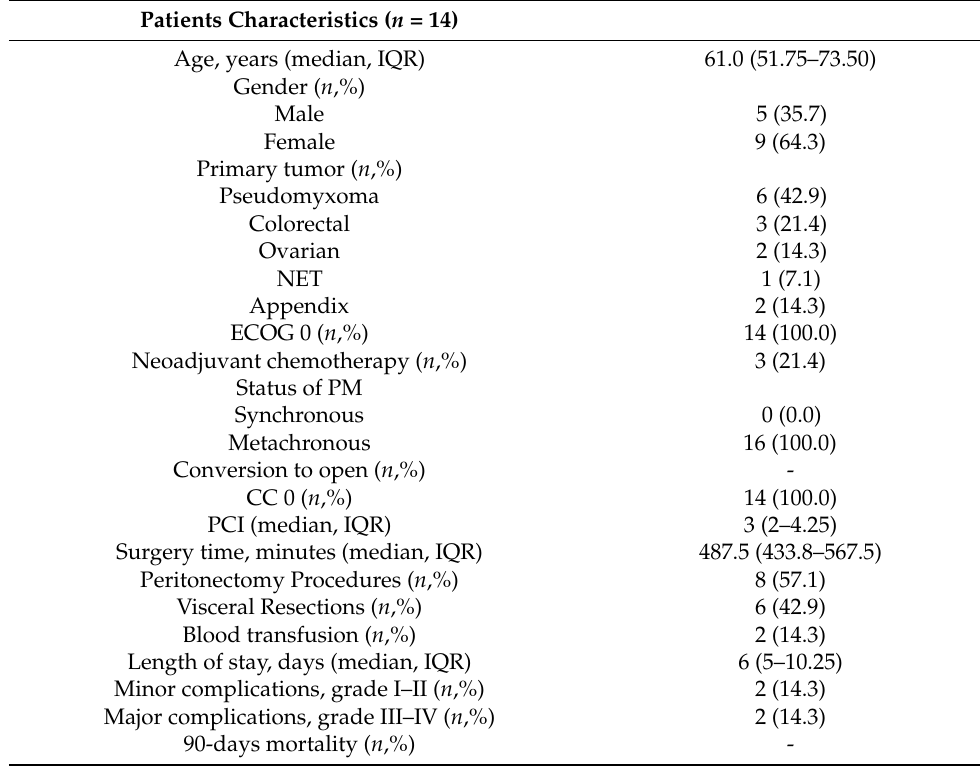
Table 1. Clinical data of patients treated with